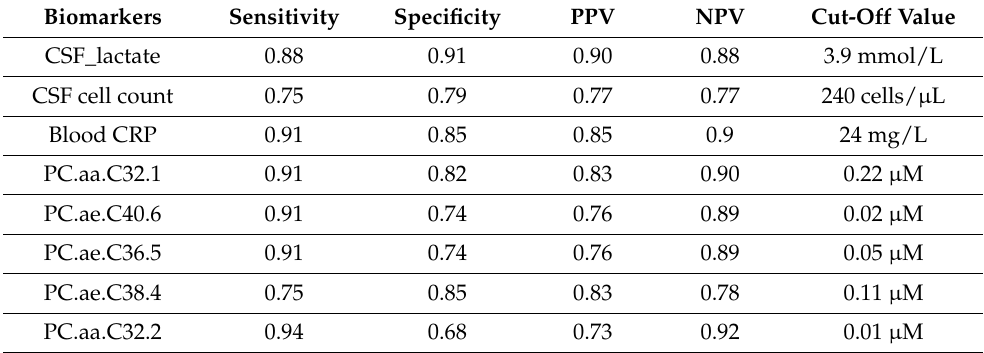
Table 3. Comparison of diagnostic parameters between CSF lactate, CSF cell count, blood CRP, and the five most accurate phosphatidylcholine